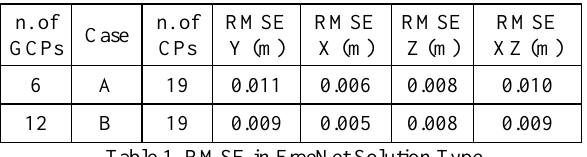
Table 1. RMSE in FreeNet Solution Type